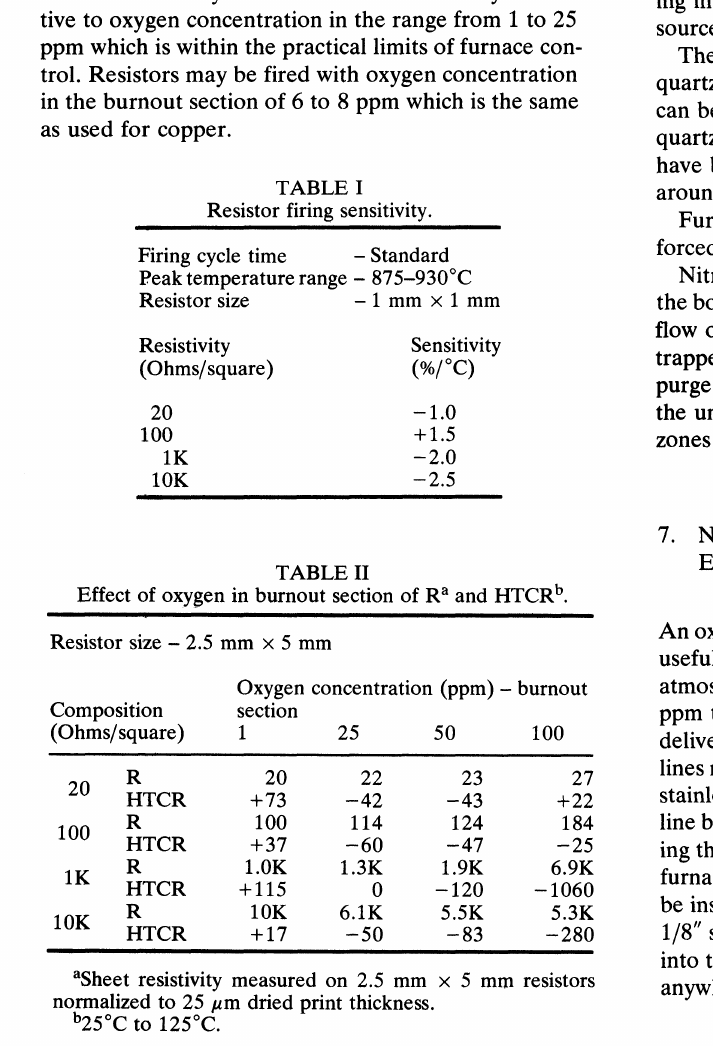
TABLE II Effect of oxygen in burnout section of R and HTCR